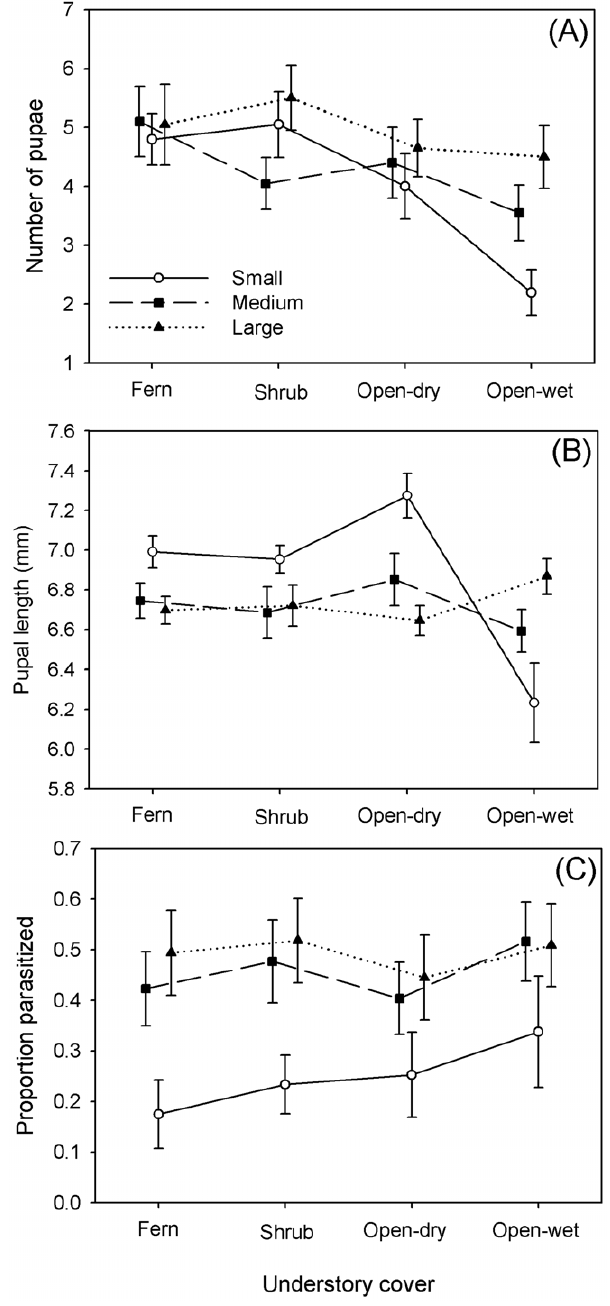
Figure 4. Performance of PLS juveniles on naturally occurring palmettos that differed in height (small=0. 5–0.55 m, medi- um=1.5–2 m, large=3.0–4.0 m) and understory cover/wetness (fern, shrub, open-dry, and open-wet). (A) Number of PLS that developed to the pupal stage, (B) pupal length (mm), and (C) the proportion of pupae parasitized. All values are means 6 SE per palmetto. doi:10.1371/journal.pone.0022331.g004 dwarf palmettos in Louisiana. The spatial eigenvector mapping (SEVM; [4]) approach indicated that no eigenvectors were informative regarding spatial structure indicating the absence of spatial autocorrelation among local populations of the PLS. This finding is similar to that of Sattler et al. [22] on the distribution of spiders, bees and birds in an urban landscape. In contrast, many